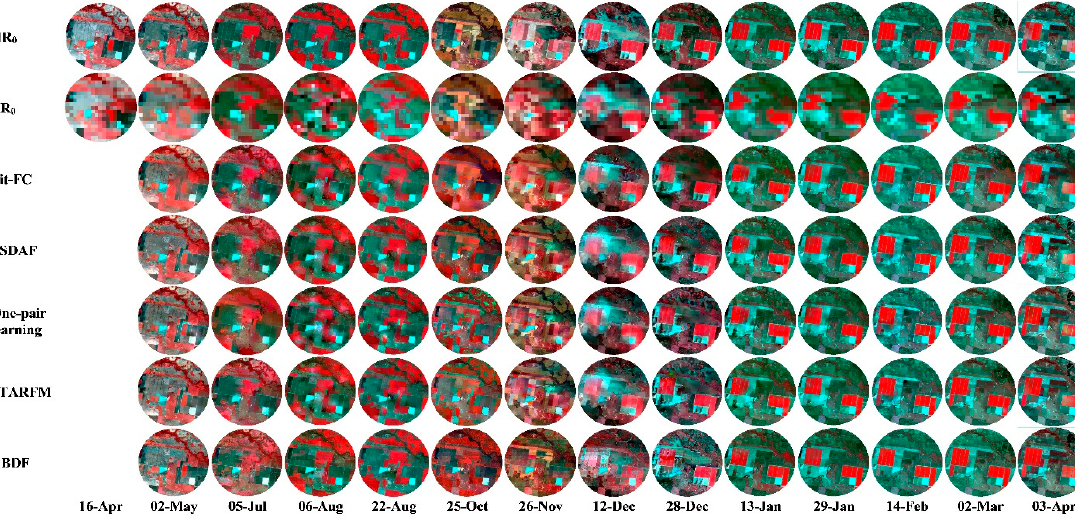
Figure A4. Observed Landsat data and simulated Landsat-like images with the fusion method indicated above for the subregion D of Gwydir in Figure 2. All images are displayed in chronological order from 2004 to 2005 (NIR, red and green as RGB).